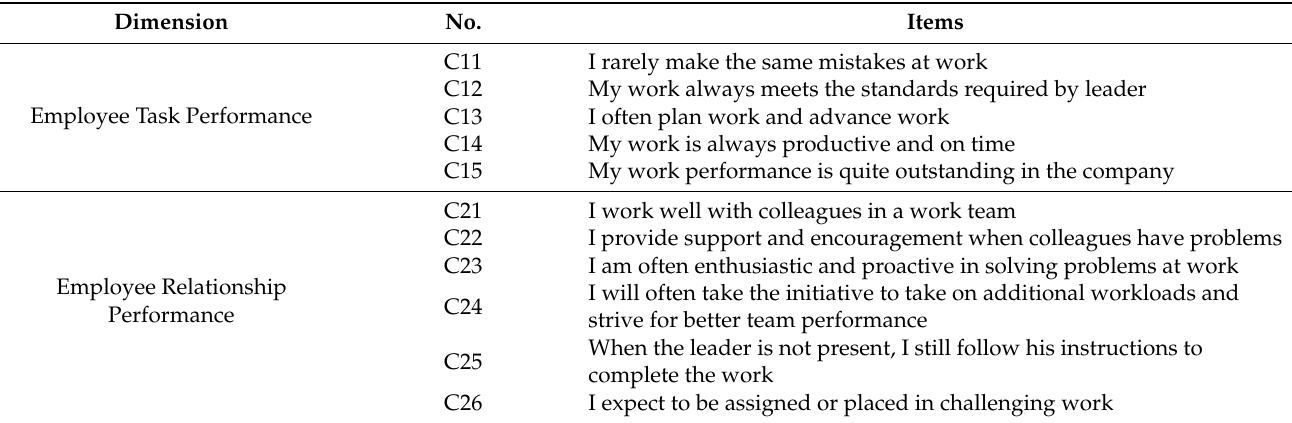
Table 3. Employee Work Performance Measurement